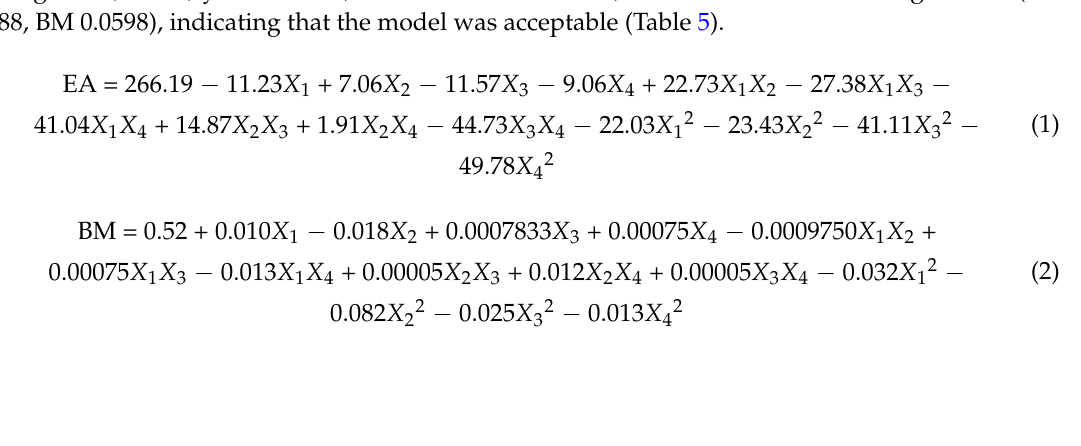
Table 4. Experiment design and result of response surface analysis.